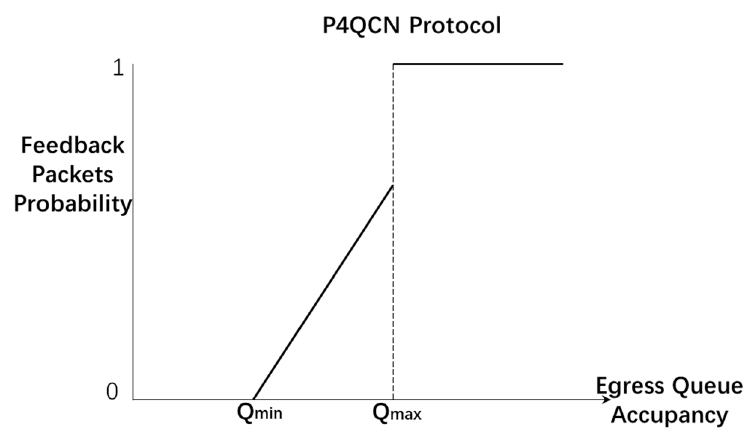
Figure 3. Feedback Packet Generation Probability.